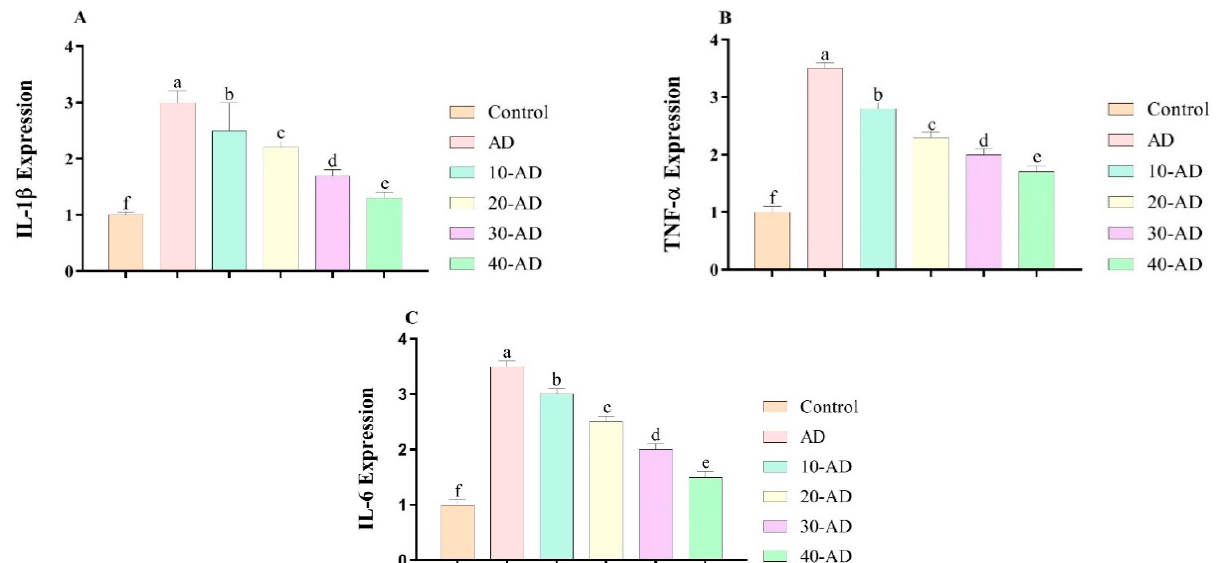
Figure 5. The effects of sake yeast on the expression of inflammatory factors in rats with Alzheimer. ( A ) IL-1 β ; ( B ) TNF- α and ( C ) IL-6. Superscript symbols (a–f) show significant differences between groups. Different superscript symbols (a–f) show significant differences between groups at p < 0.05.